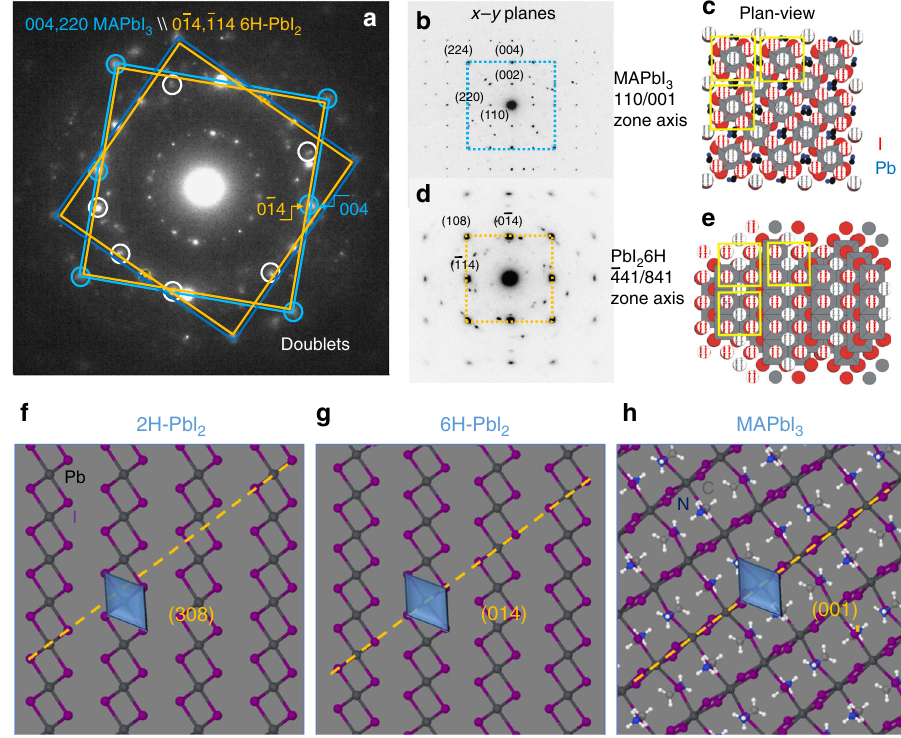
Fig. 3 Three-dimensional structural coupling between MAPbI 3 and PbI 2 . a Electron diffraction (integration time = 4s, t = 200 s, total dose 200 e − /A 2 ) taken in a smaller area than that used for Fig. 2a to reduce the number of grains and thus to highlight the lattice coupling at each doublet alignment (some doublets are circled in white or light blue). Light blue and dark yellow squares (also reproduced in b and d ) connect spots of the same zone axis in the MAPbI 3 grain transforming into a corresponding 6H-PbI 2 grain: they focus on how one lattice changes into the other. b , d Selected area electron diffraction on MAPbI 3 and 6H-PbI 2 single grains and c , e simulated atoms alignment on the basal plane (dashed dots are coplanar atoms) showing MAPbI 3 /PbI 2 mutual relationship. The layer thickness is 40 nm. Light yellow squares in c , e lie in the plane of the tetrahedron containing four iodine species and one lead atom: they highlight how the transformation preserves in-plane atomic con fi gurations. f – h Schematic showing the atomic arrangement along diagnostic planes in MAPbI 3 and two observed polymorphisms (for MAPbI 3 and 6H-PbI 2 taken from the corner planes in b and d , respectively): moving from MAPbI 3 to 6H-PbI 2 is easier than to 2H-PbI 2 due to the closer atomic con fi guration. The yellow line is a guide for eyes to follow the octahedron alignment that is identical in the MAPbI 3 and 6H-PbI 2 . Octahedra (represented in blue) are instead spatially shifted in nearby layers in the 2H-PbI 2 lattice with respect to